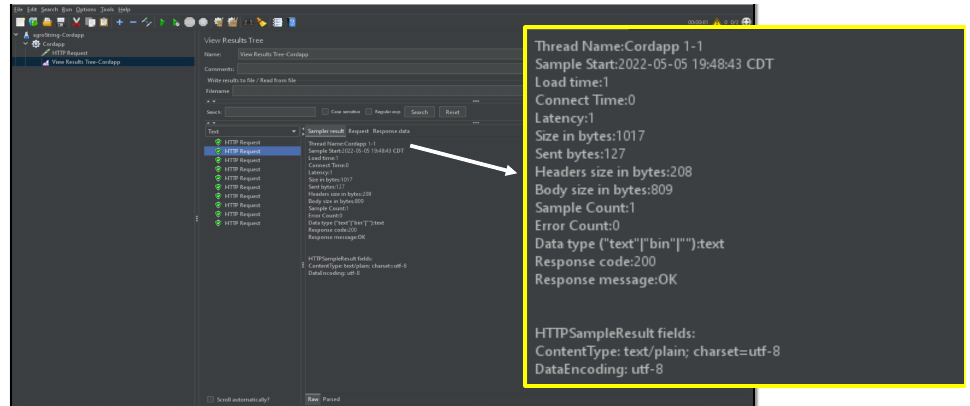
Figure 9. Performance Test for Corda